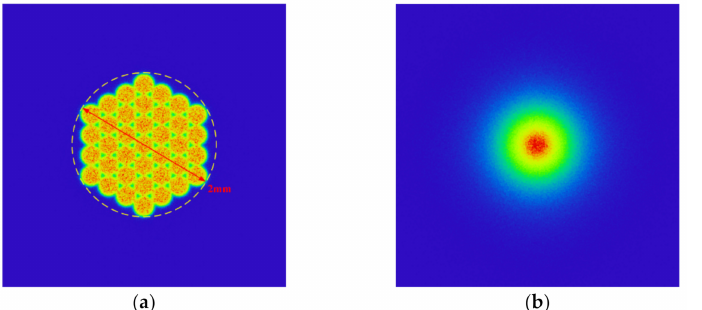
Figure 4. Light spots of fiber-coupled semiconductor lasers at different distances: ( a ) A distance of 0.05 mm; ( b ) A distance of 5 mm.